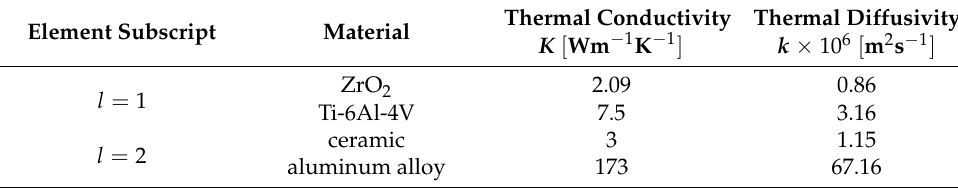
Table 1. Thermophysical properties of the FGM components [15,25]. Element